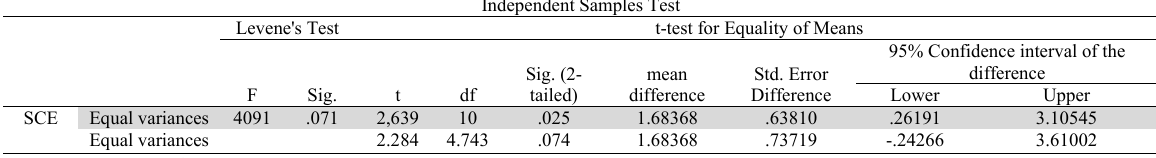
Std. Error Difference